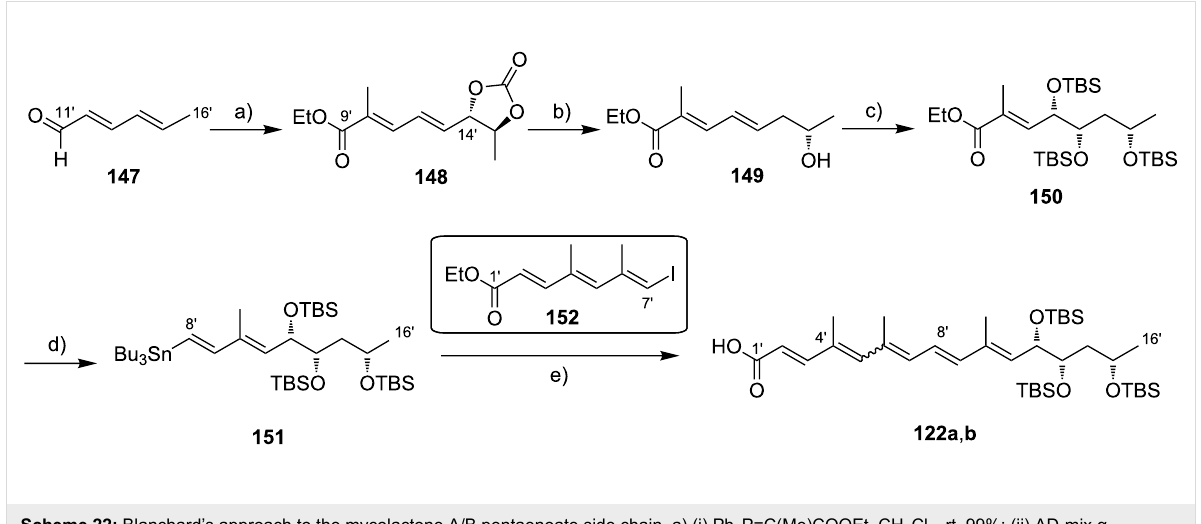
Scheme 22: Blanchard’s approach to the mycolactone A/B pentaenoate side chain. a) (i) Ph 3 P=C(Me)COOEt, CH 2 Cl 2 , rt, 99%; (ii) AD-mix α ,